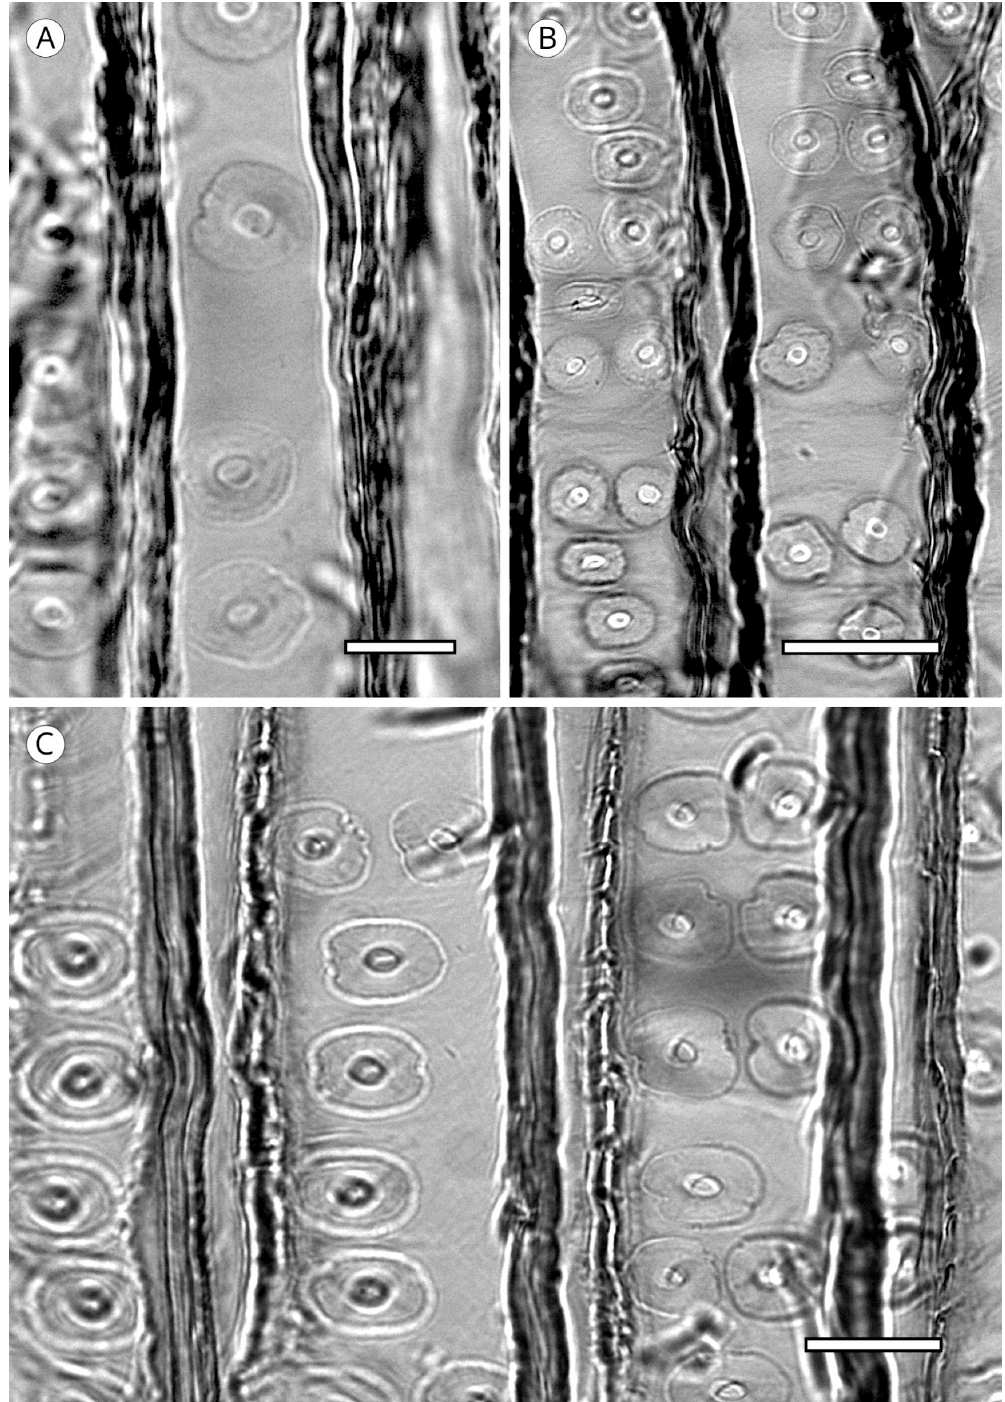
Figure 16. Notched borders. ( A ) Calocedrus decurrens (Torr.) Florin; ( B ) Athrotaxis cupressoides D.Don; ( C ) Taiwania cryptomerioides Hayata. Scale bars. ( A – C ) = 25 μ m. ( C ) Taiwania cryptomerioides Hayata. Scale bars. ( A – C ) = 25 µ